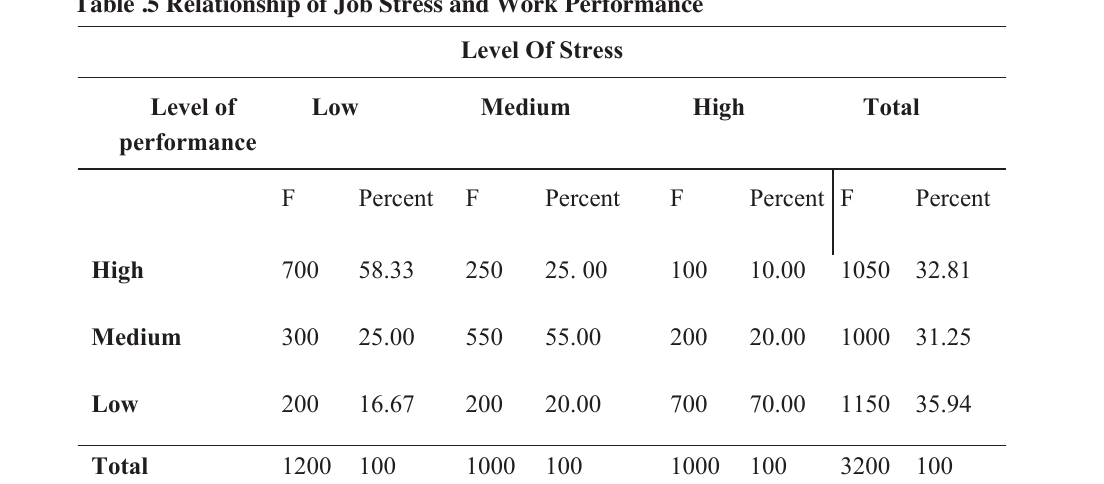
Table .5 Relationship of Job Stress and Work